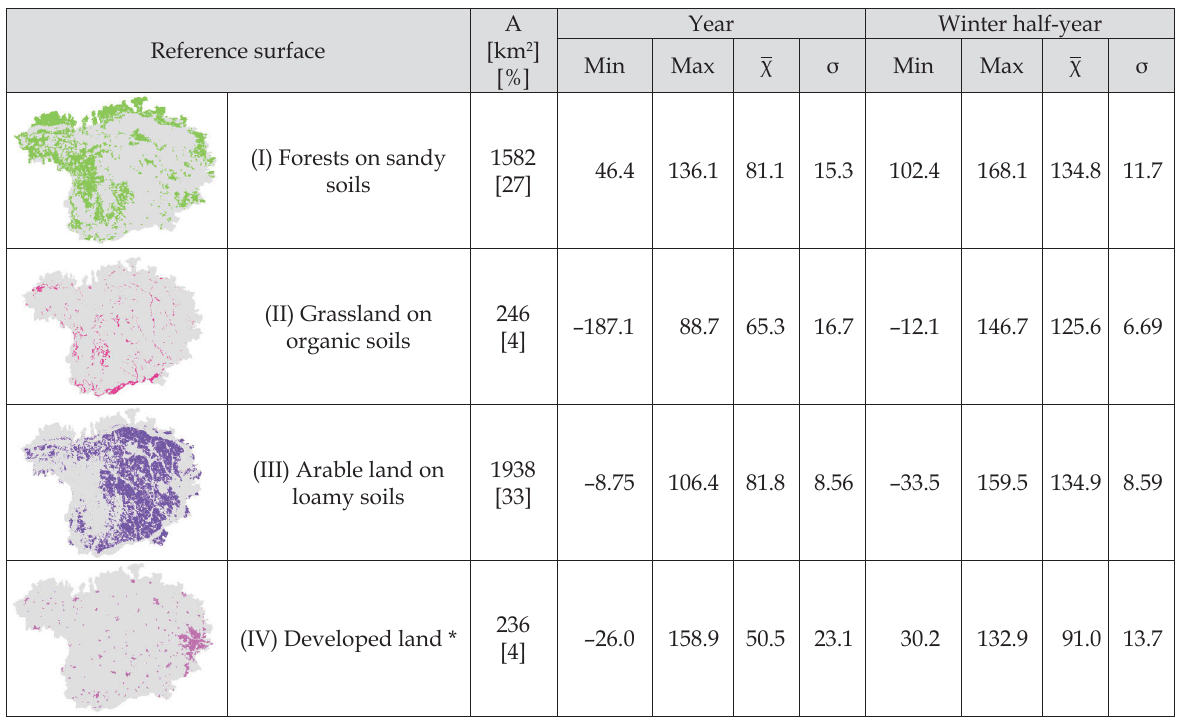
Table 3. Selected statistics of effective infiltration values [mm] for selected reference surface patterns in the Poznan Plateau region – WetSpass model results for the year and the winter half-year (1961–2000)